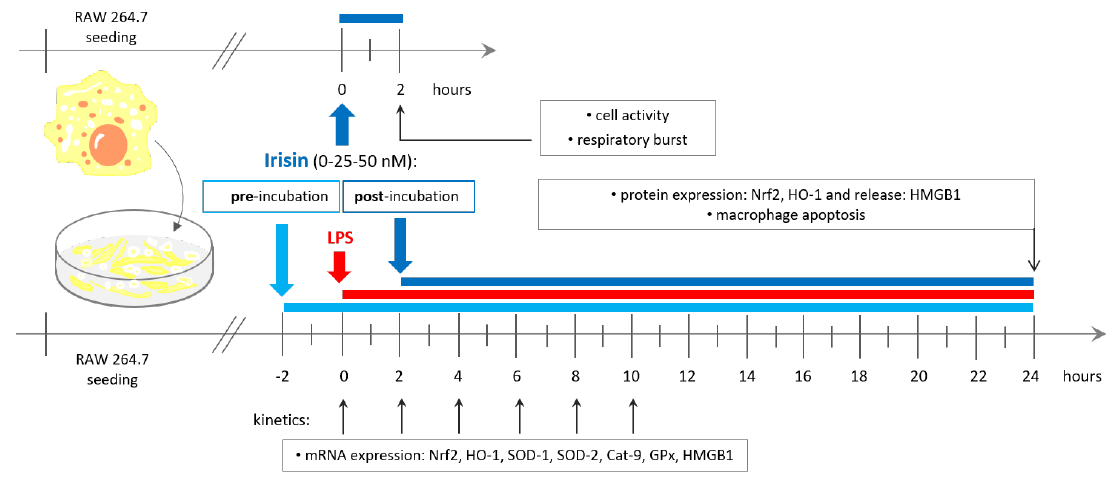
Figure 1. Schematic diagram representing the timelines for irisin administration to RAW 264.7 macrophages. The cells were stimulated with lipopolysaccharide (LPS; 100 ng/mL), treated with irisin (0, 25, or 50 nM) 2 h before (pre-incubation) and 2 h after (post-incubation) LPS activation, and harvested at six time points (0, 2, 4, 6, 8, or 10 h) for the gene expression studies or 24 h for the analysis of protein expression and release, as well as the determination of macrophage apoptosis. Overall activity and respiratory burst were also assessed after 2 h incubation of irisin with RAW 264.7 cells. Nrf2: nuclear factor erythroid 2-related factor 2; HO-1: heme oxygenase-1; SOD-1: superoxide dismutase 1; SOD-2: superoxide dismutase 2; Cat-9: catalase 9; GPx: glutathione peroxidases; HMGB1: high-mobility group box 1.